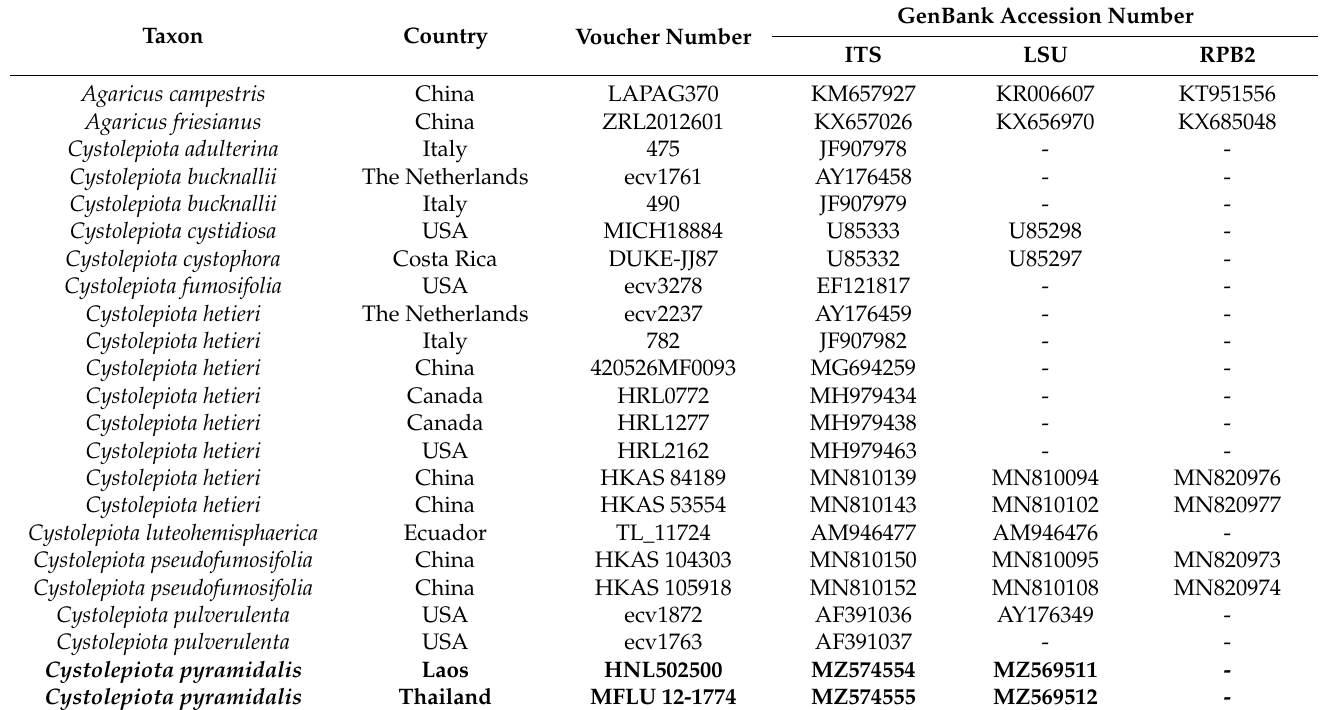
Table 1. GenBank accession numbers, geographical origins, and voucher numbers of taxa used